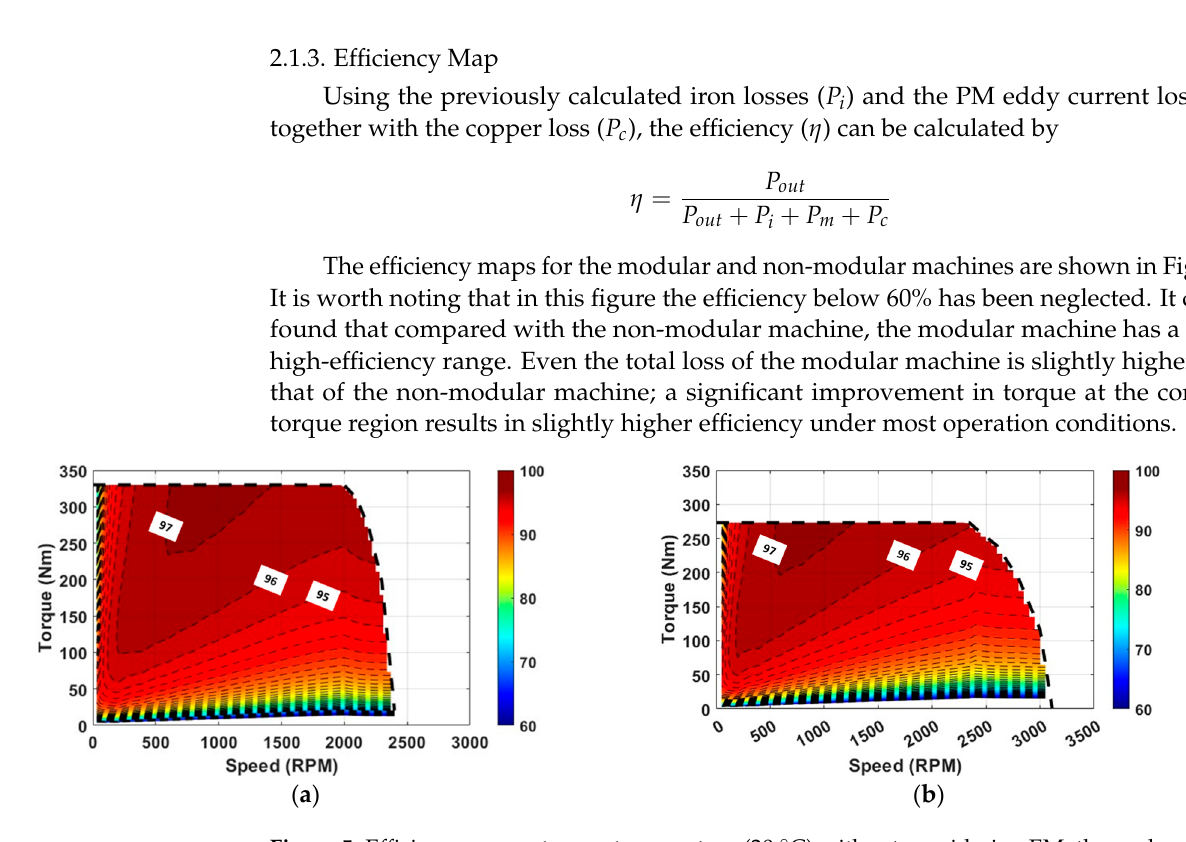
Figure 4. Losses-speed curves for the modular and non-modular machines operating at room tem- perature (20 °C).